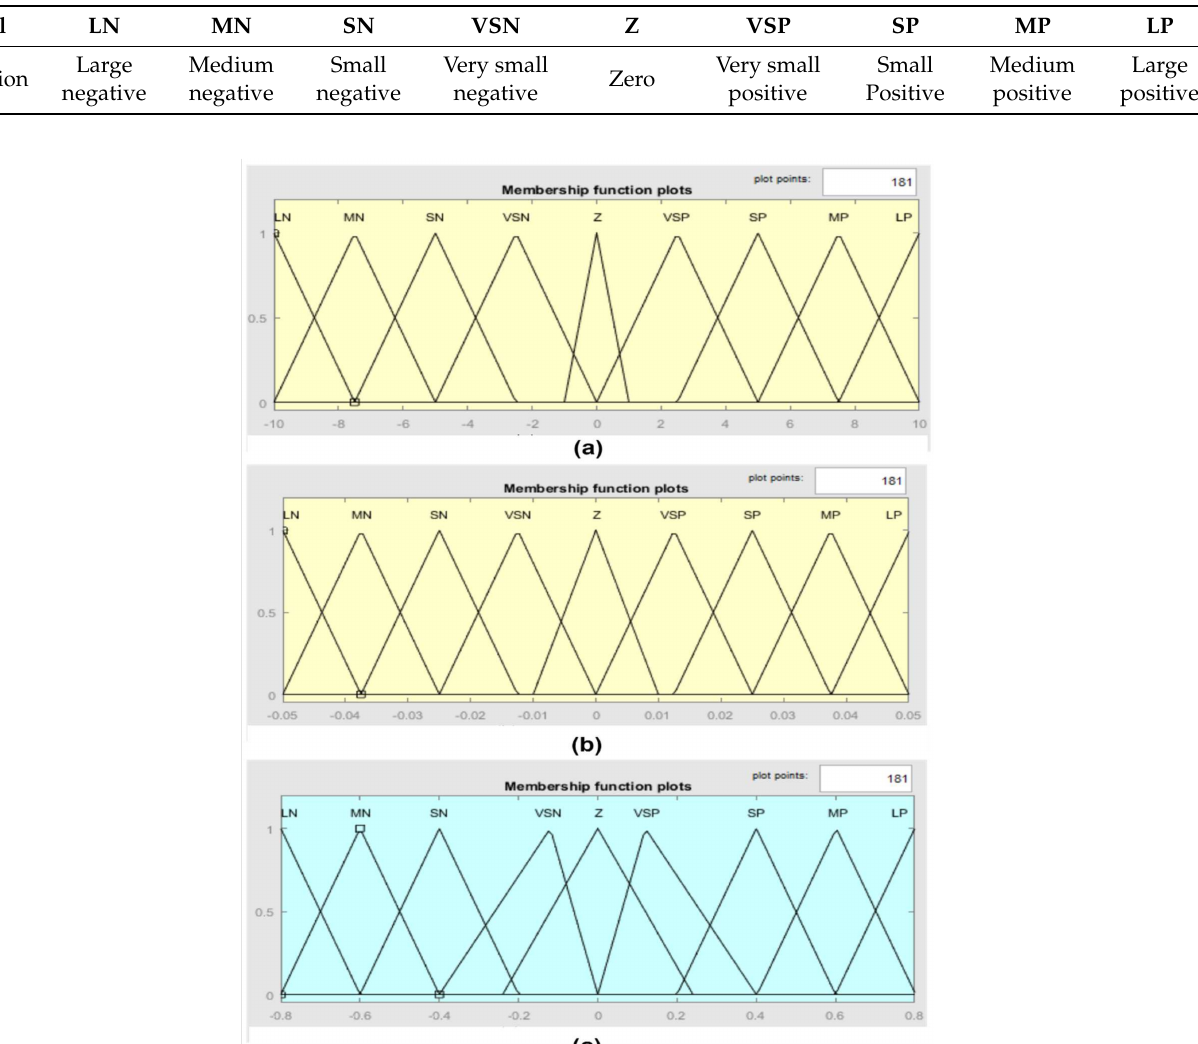
Table 1. Linguistic labels for the inputs and outputs.